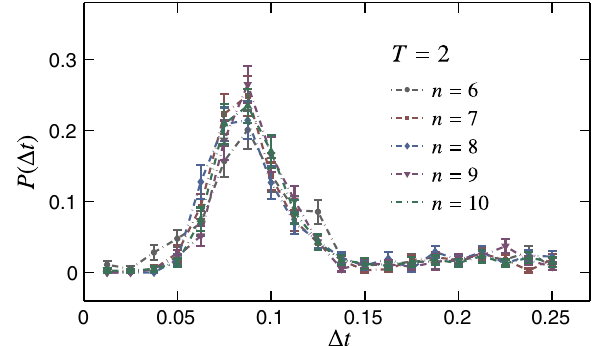
FIG. 3. The average probability distribution of the time scales of bangs for different system sizes: n ¼ 6 , 7, 8, 9, and 10. The total annealing time is fixed to be T ¼ 2 , leading to an average success rate around 0.33 – 0.47, depending on the system sizes. Each curve is averaged over 50 instances of Hamiltonian Eq.